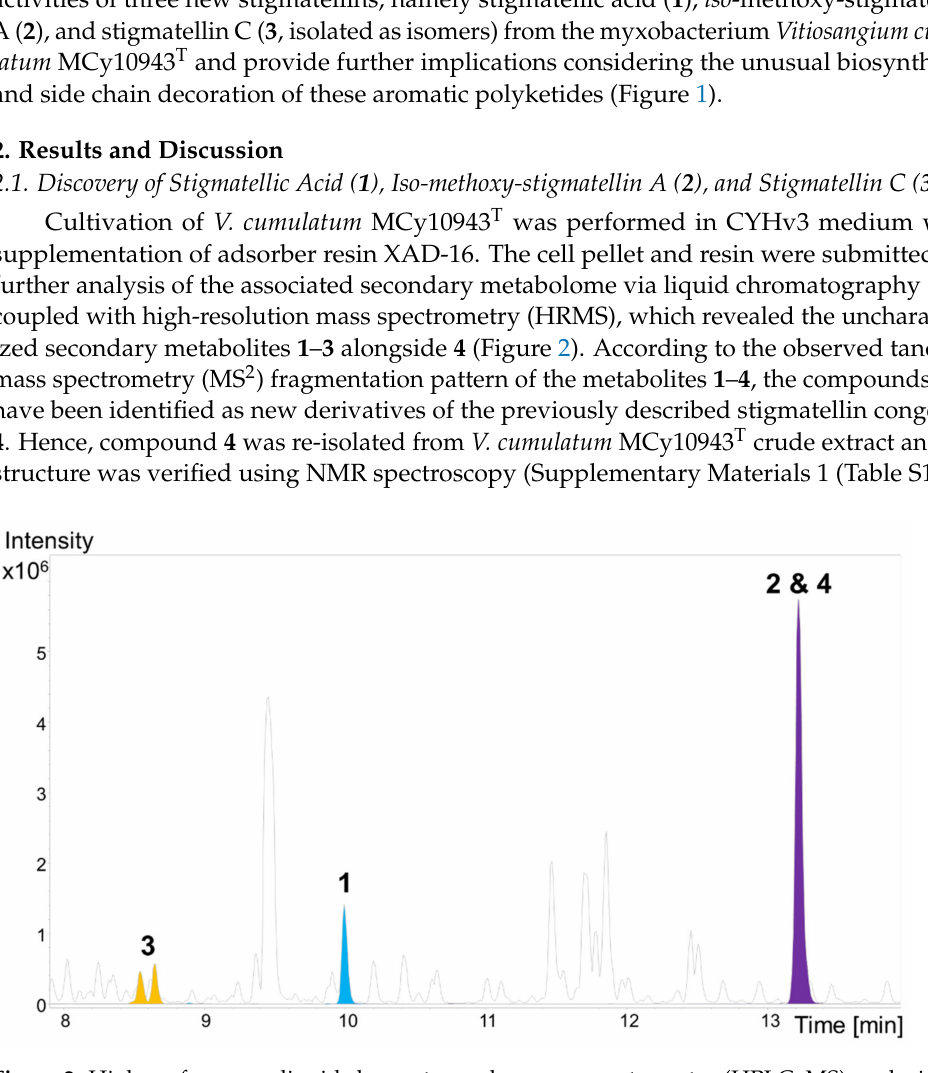
Figure 2. High performance liquid chromatography–mass spectrometry (HPLC–MS) analysis dis- playing the base peak chromatogram (grey) and extracted ion chromatograms (EICs) of 1 ([M + H] + 545.2755 m / z , blue), 2 and 4 ([M + H] + 515.3004 m / z , purple), and 3 ([M + H] + 549.3060 m / z and 549.3064, orange) from V. cumulatum MCy10943 T crude